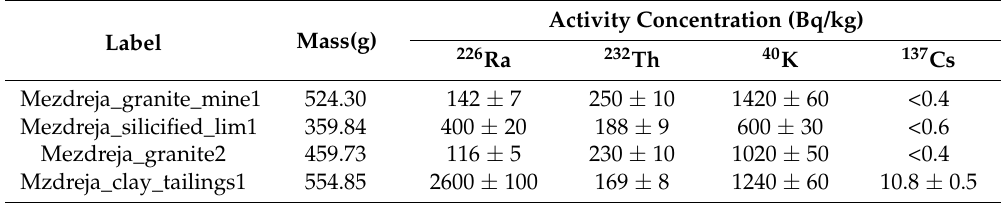
Table 1. Radioactivity of characteristic samples from the Mezdreja mine area.